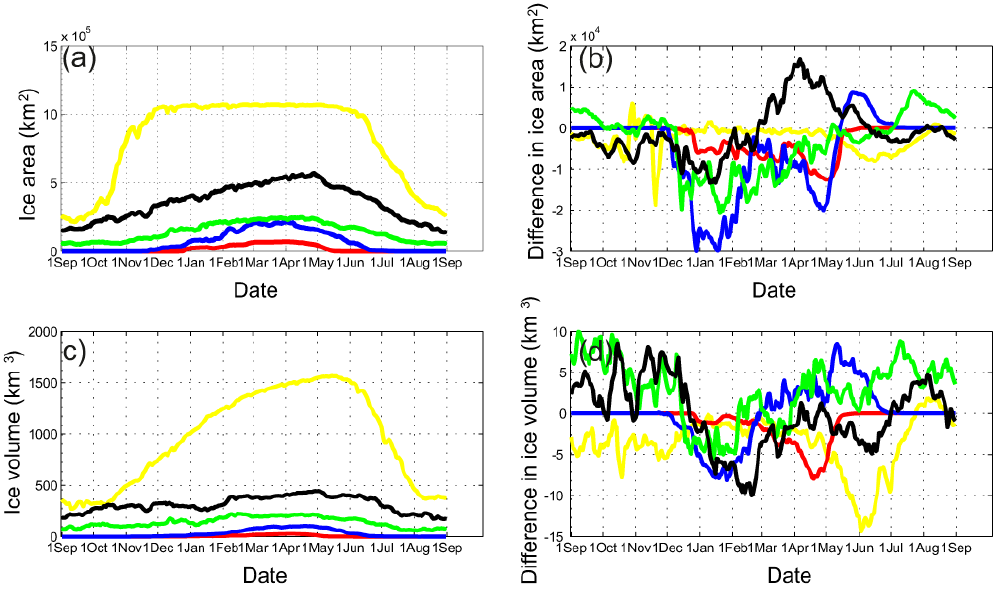
Fig. 6. (a) Daily ice area integrated over the subdomains shown in Fig. 2b for the control model run. (b) Difference in ice area between the model run with and without tidal forcing integrated over each subdomain. Positive values indicate that the total ice area is greater with tidal forcing than without. (c) and (d) as above but for ice